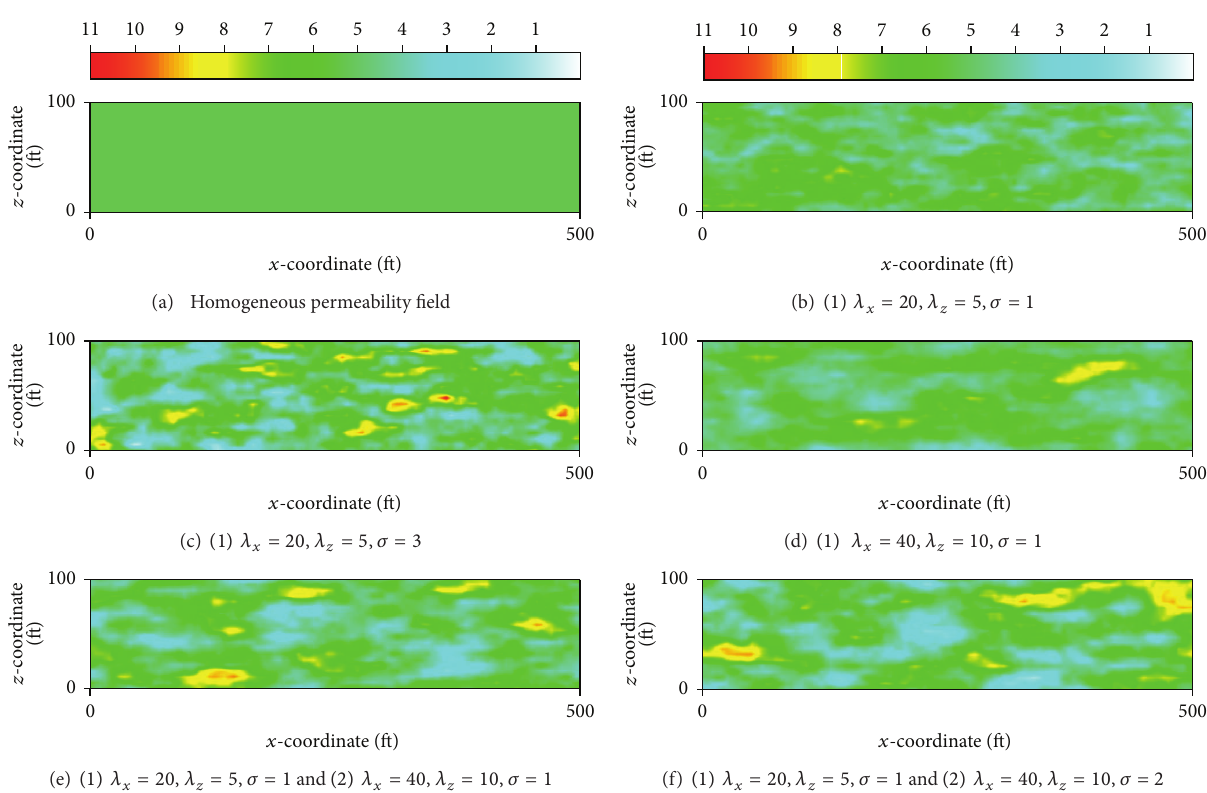
Figure 1: Homogeneous permeability field (a) and heterogeneous permeability fields depending on single-scale correlation ((b), (c), and (d)) and multiscale correlation ((e) and (f)) expressed with ln 𝑘